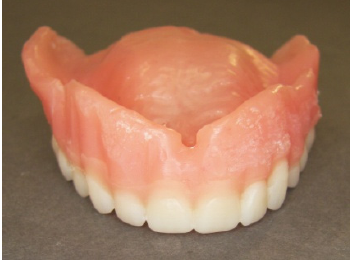
Figure 21. Denture after teeth bonding.